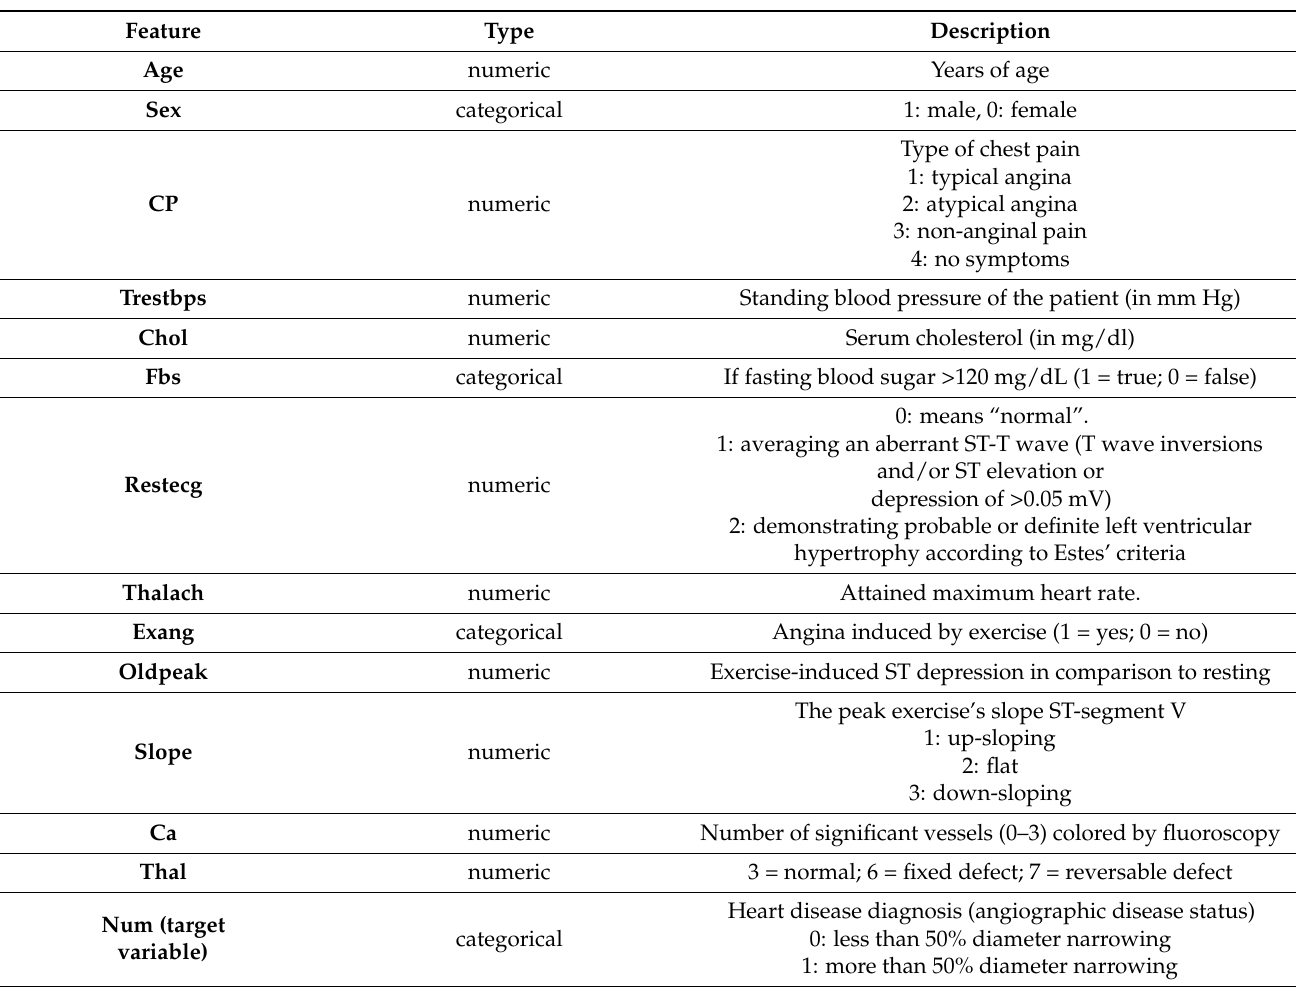
Table 4. Description of the dataset